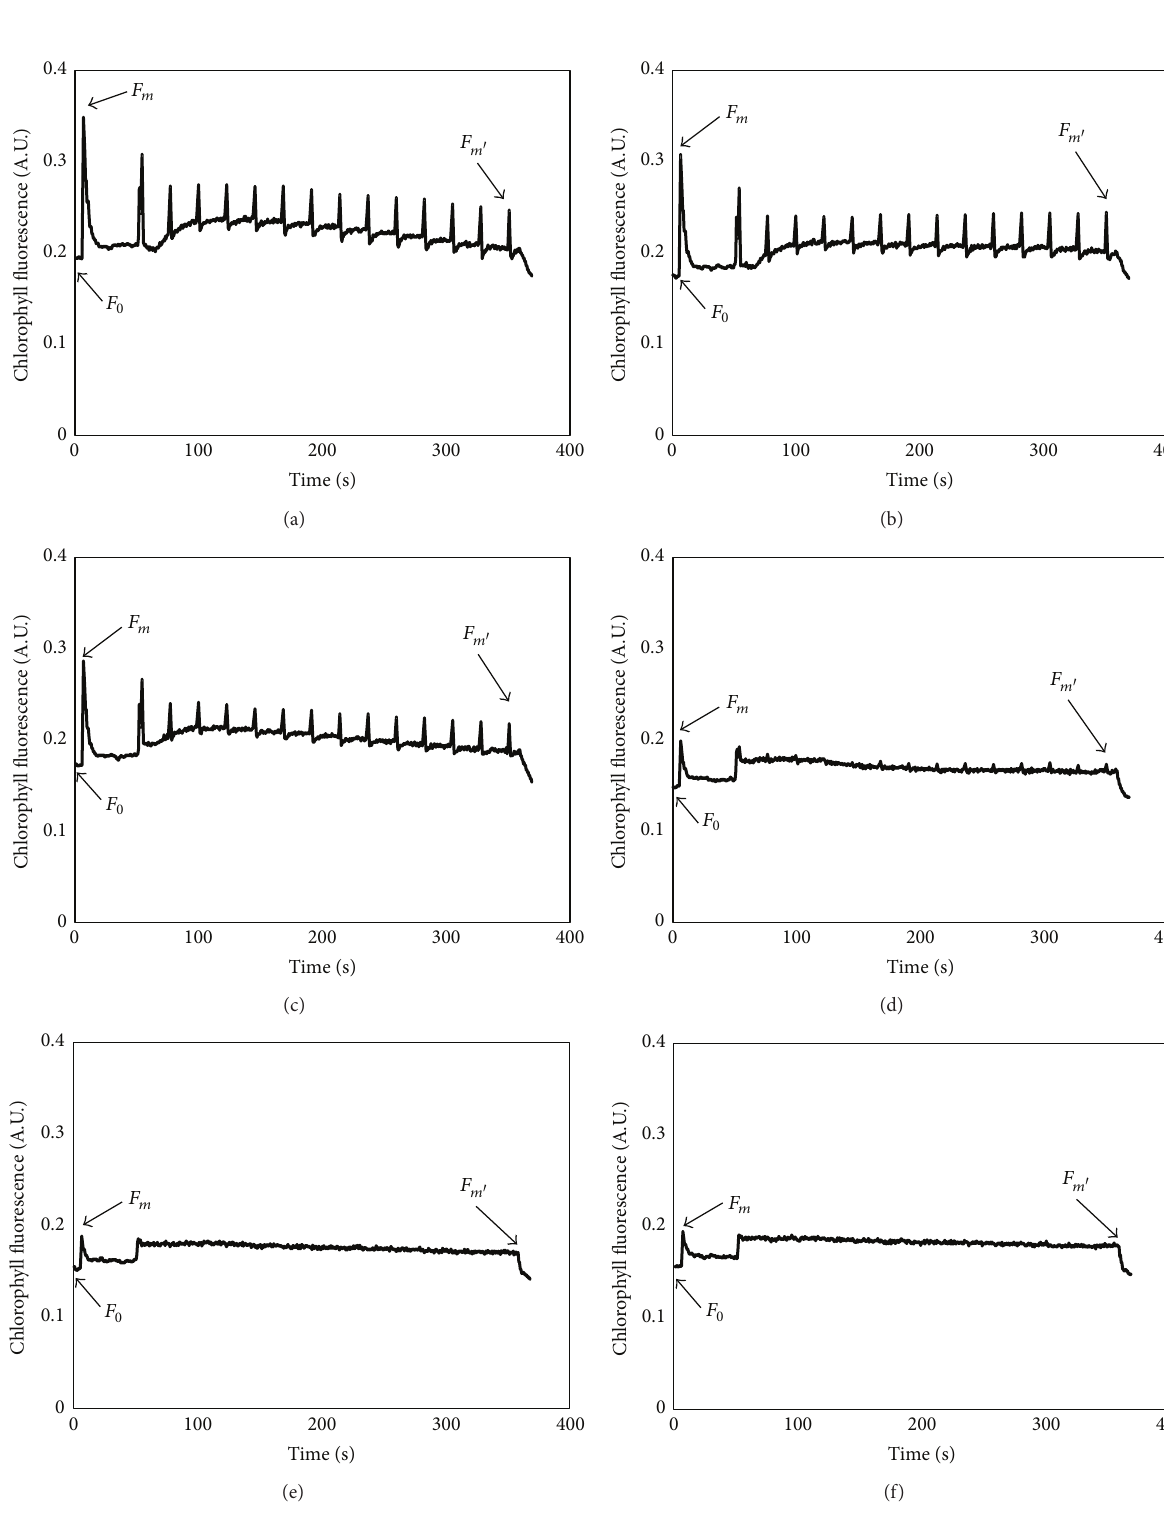
Figure 2: The photoinduced curves of Chlorella vulgaris after 24 h of exposure to ethyl cinnamate. ((a) Blank control, (b) 0.5 mg/L treatment, (c) 1mg/L treatment, (d) 2mg/L treatment, (e) 3 mg/L treatment, and (f) 4 mg/L